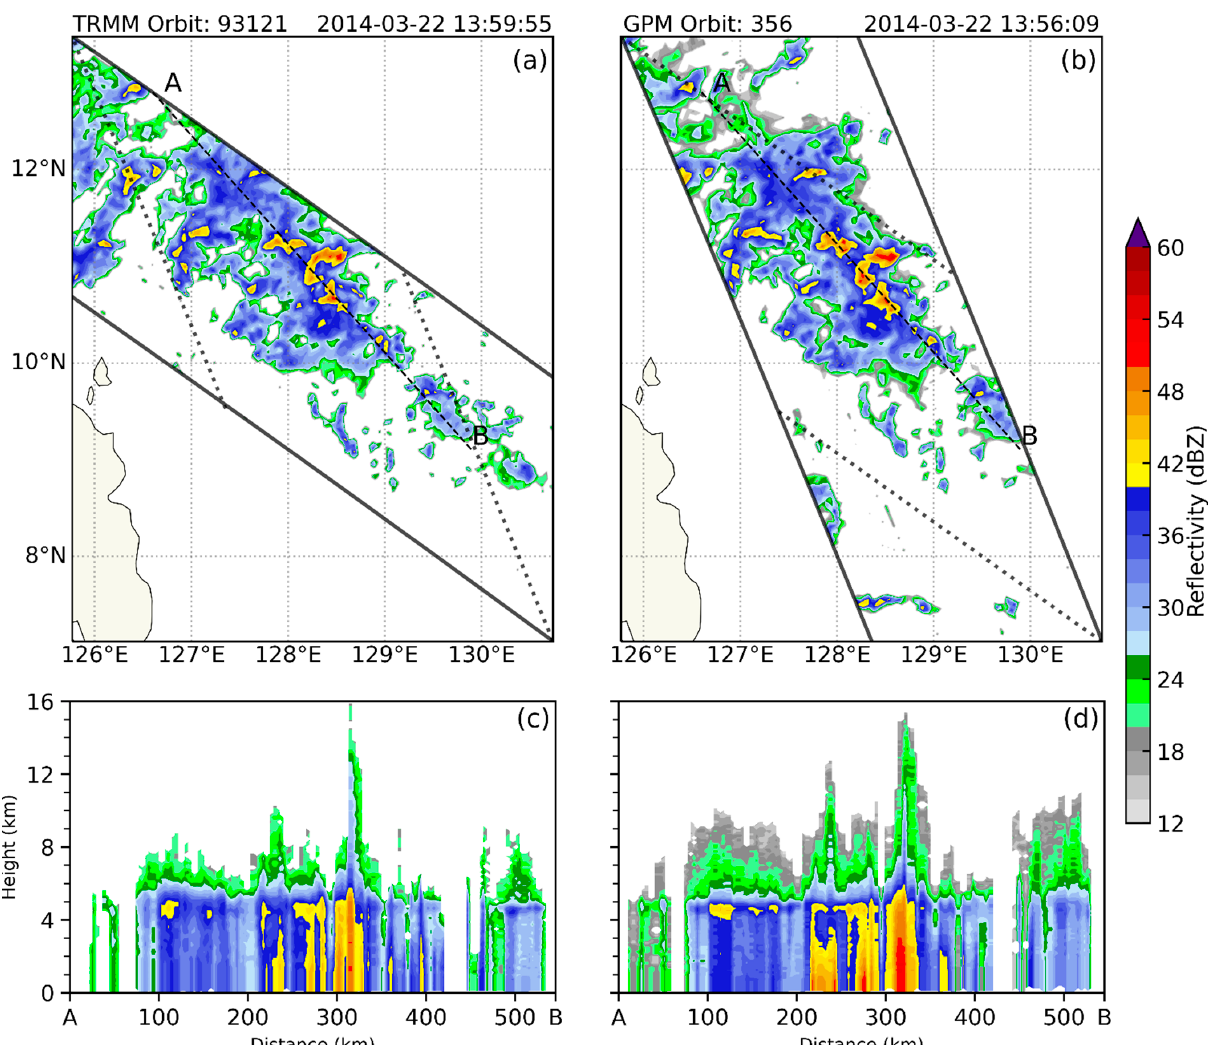
Figure 3. A precipitation system observed by the TRMM_PR (left column, orbit #93121, at about 14:00 UTC) and GPM_KuPR (right column, orbit #356, at about 13:56 UTC) on 22 March 2014. ( a , b ) The nearSurfdBZ and ( c , d ) the VPR (corresponding to the dashed line highlighted by points A and B). The solid lines represent the orbit edges of the TRMM_PR/GPM_KuPR in ( a , b ) and vice versa for the dotted lines. The coincident regions are highlighted within both solid and dotted